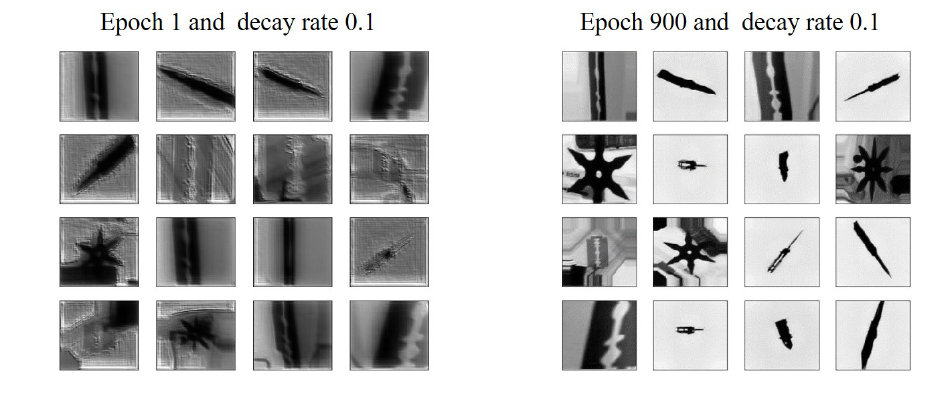
Figure 11. Generated images of learning rate with decay rate 0.1.